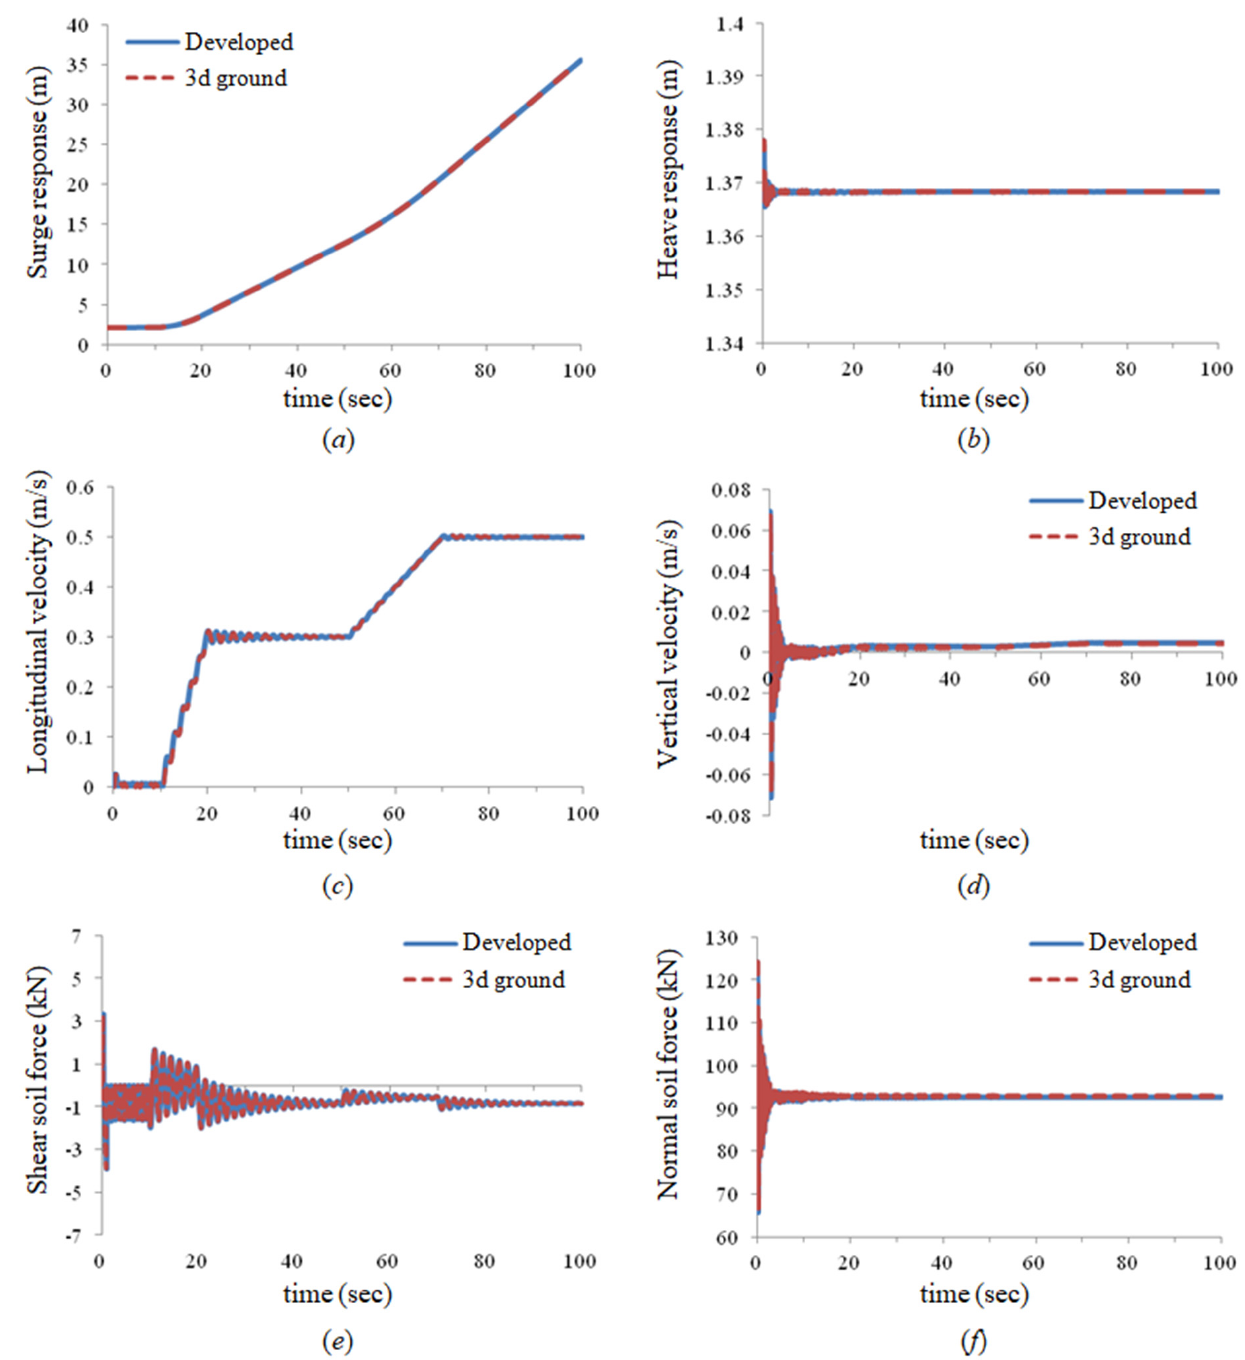
Figure 32. Comparison of the straight drive dynamic analysis results between the developed method and 3D ground model: ( a ) surge response of the mining robot, ( b ) heave response of the mining robot, ( c ) longitudinal velocity of the mining robot, ( d ) transverse velocity of the mining robot, ( e ) shear soil contact force acting on mining robot, ( f ) normal soil contact force acting on mining robot.